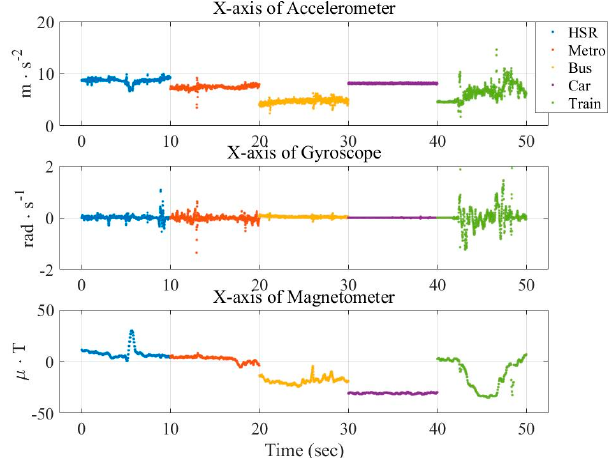
Figure 3. Distribution of raw data from three sensors (x-axis) in the vehicular mode.